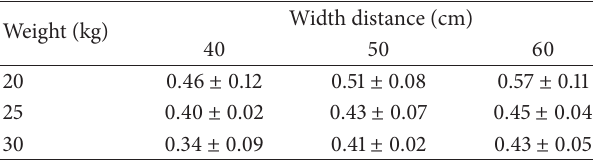
Table 1: Average angular velocity for a complete arm flexion move- ment under different loads (unit: ∘